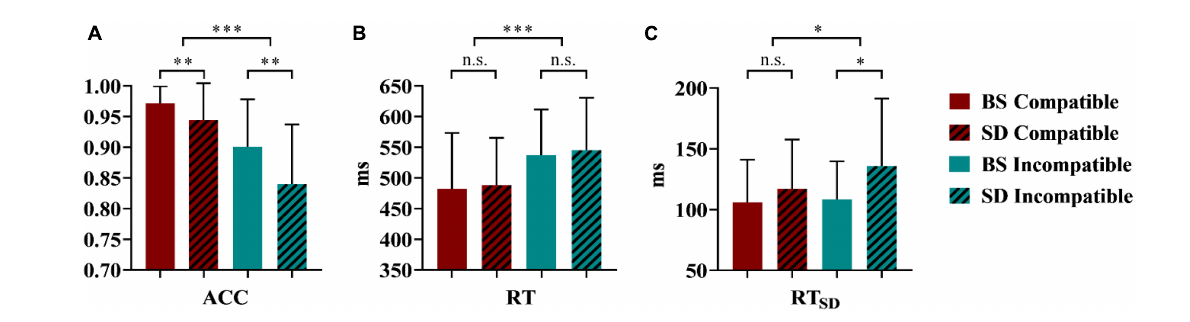
FIGURE3 Behavioral results of ACC (A) , RT (B) , RT SD (C) in the stimulus-response compatibility visual search task after a full night’s sleep (at baseline) versus after total sleep deprivation (TSD). ACC, accuracy; RT, response time; RT SD , response time variance; BS, at baseline; SD, after total sleep